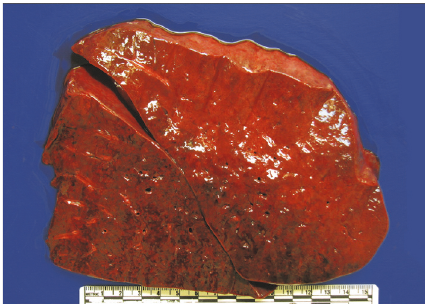
Figure3:Grossphotooflungcutsurface.Thelungwassolid,devoid of the usual